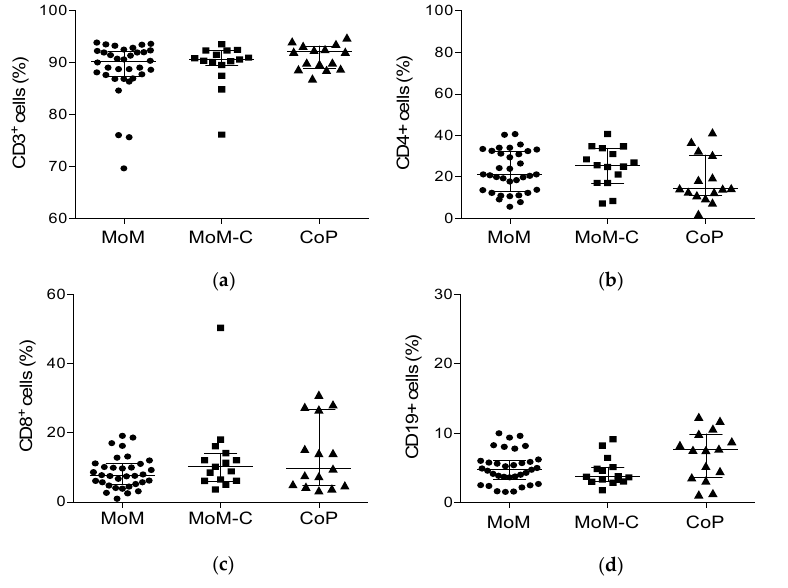
Figure 2. Scatter plots summarizing the results of phenotypic analysis of lymphocyte subpopulations as measured by flow cytometry. The figure presents the percentages as frequencies of CD3 + cells of: ( a ) CD3 + T cells; ( b ) CD4 + T helper cells ( c ) CD8 + cytotoxic T cells; and ( d ) CD19 + B cells. No statistically significant di ff erences were found between the groups. Vertical scatterplot lines show medians with interquartile range. MoM, metal-on-metal study group; MoM-C, metal-on-metal control group; CoP, ceramic-on-polyethylene group.